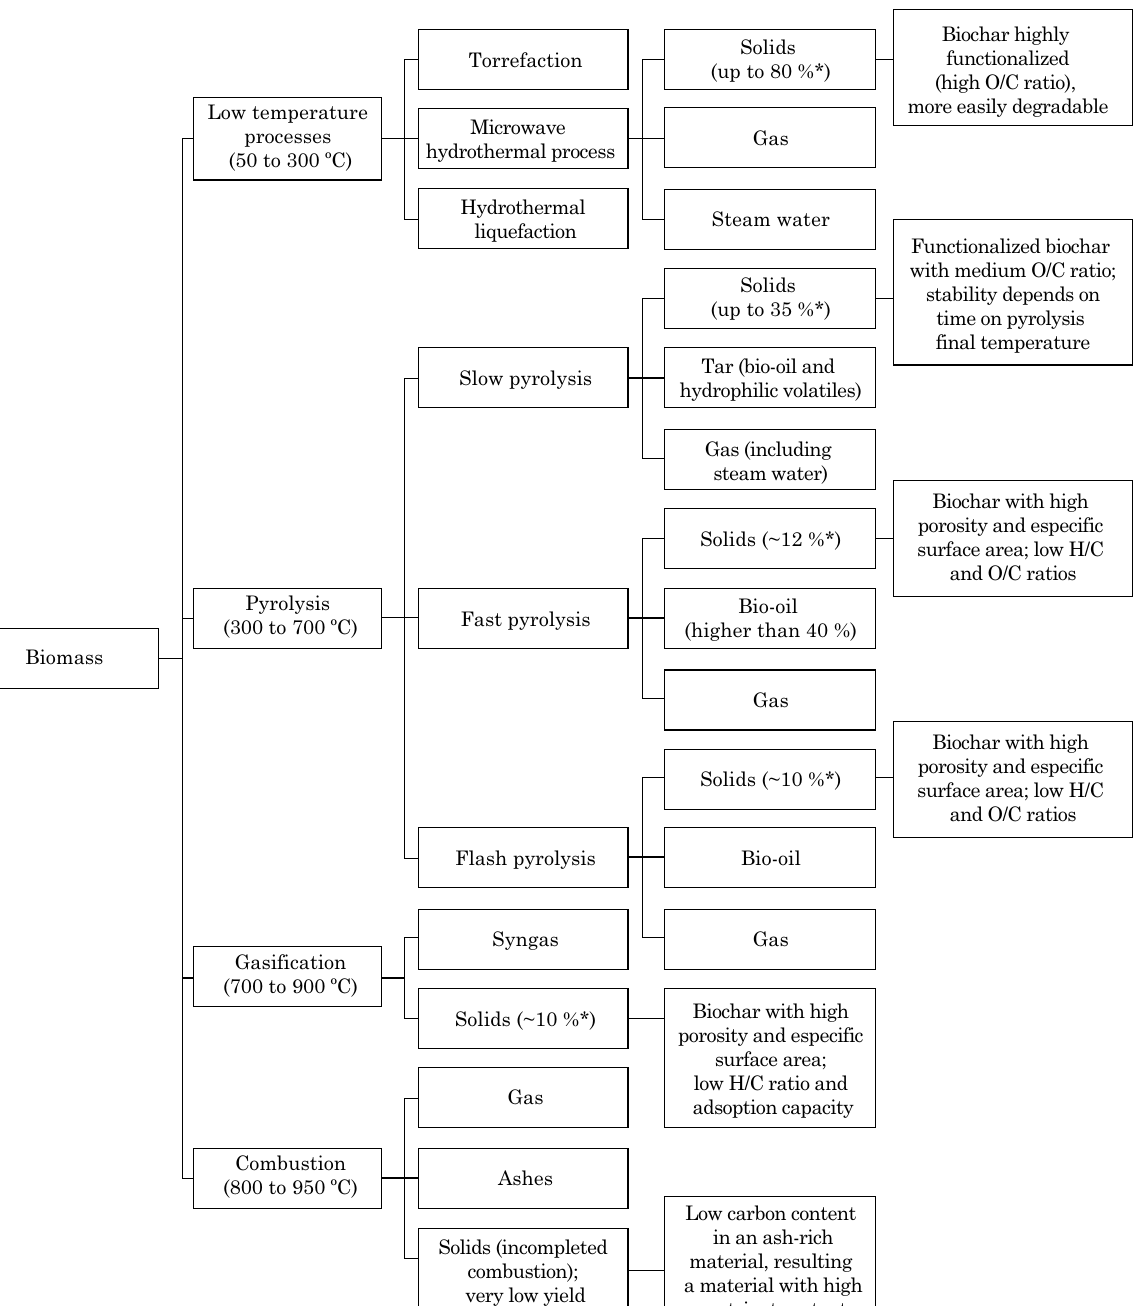
Figure 2. Thermochemical processes of biomass production, according to the temperature range and predominant biochar characteristics (*Bridgwater,